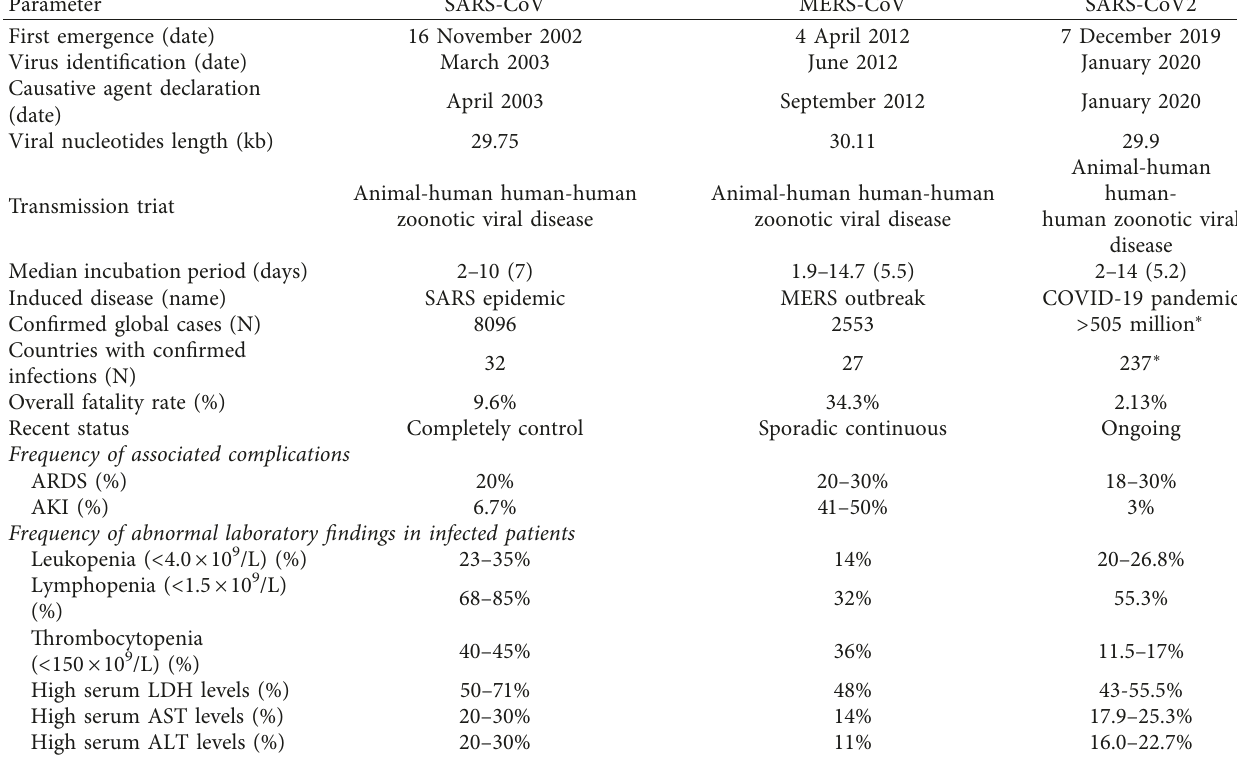
Table 1: A comparative overview of SARS-CoV, MERS-CoV, and SARS-CoV-2 [2, 5, 7, 12, 13, 16, 41, 45, 49, 71–74]. Parameter